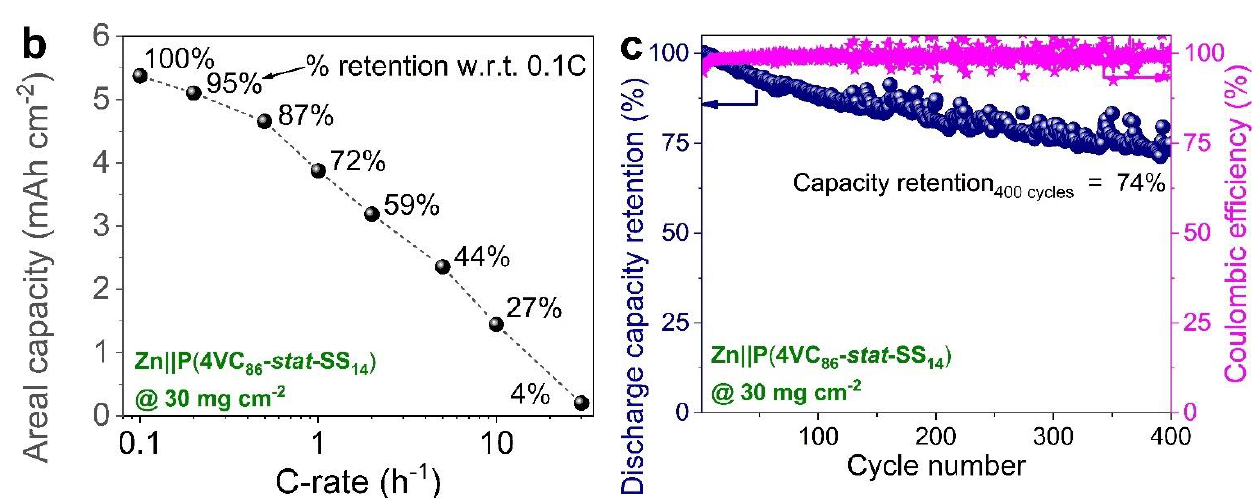
Figure 6. Electrochemical performance of Zn||P(4VC 86 - stat -SS 14 ) cell at a high mass loading of 30 mg cm − 2 . ( a , b ) rate performance: representative specific capacity-voltage profiles ( a ), and the corresponding areal capacity retention at different C-rates ( b ). The discharge capacities at higher C-rates are normalized with respect to the discharge capacity at 0.1 C. ( c ) Cyclic performance: discharge capacities and Coulombic efficiencies measured at 1 C.